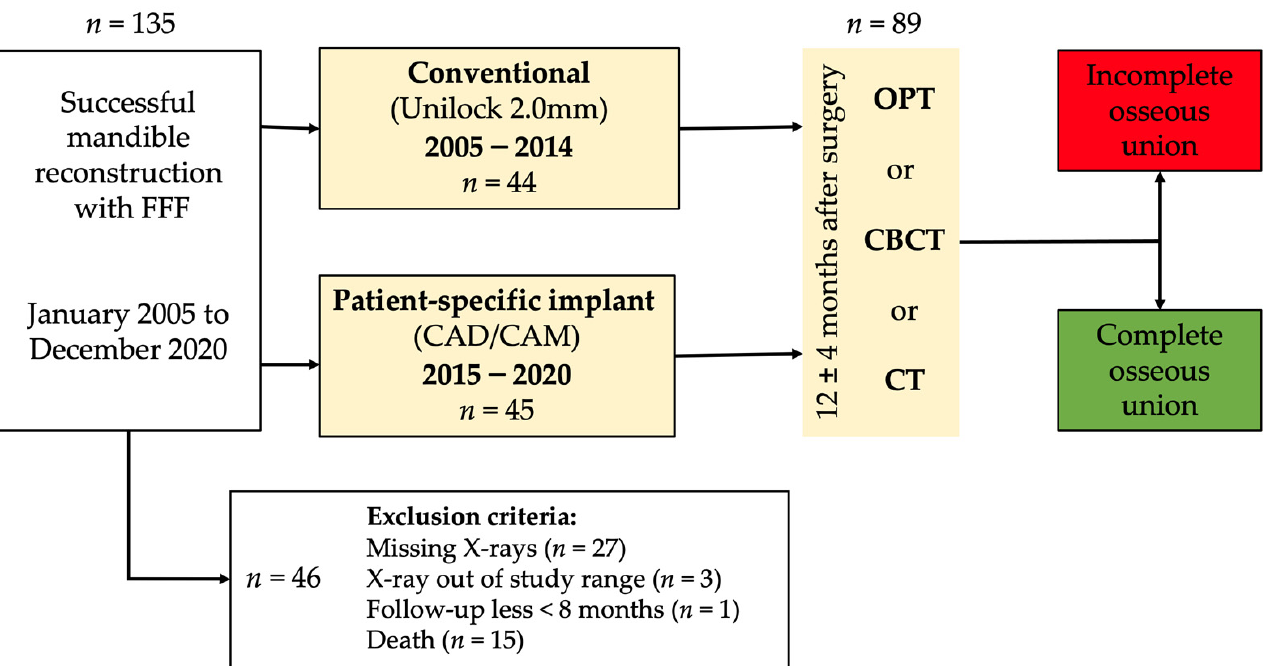
Figure 1. Schematic study design. OPT: Panoramic radiograph; CT: computed tomography; CBCT: cone-beam CT; CAD: computer-aided design; CAM: computer-aided manufacturing; FFF: fibula free flap.